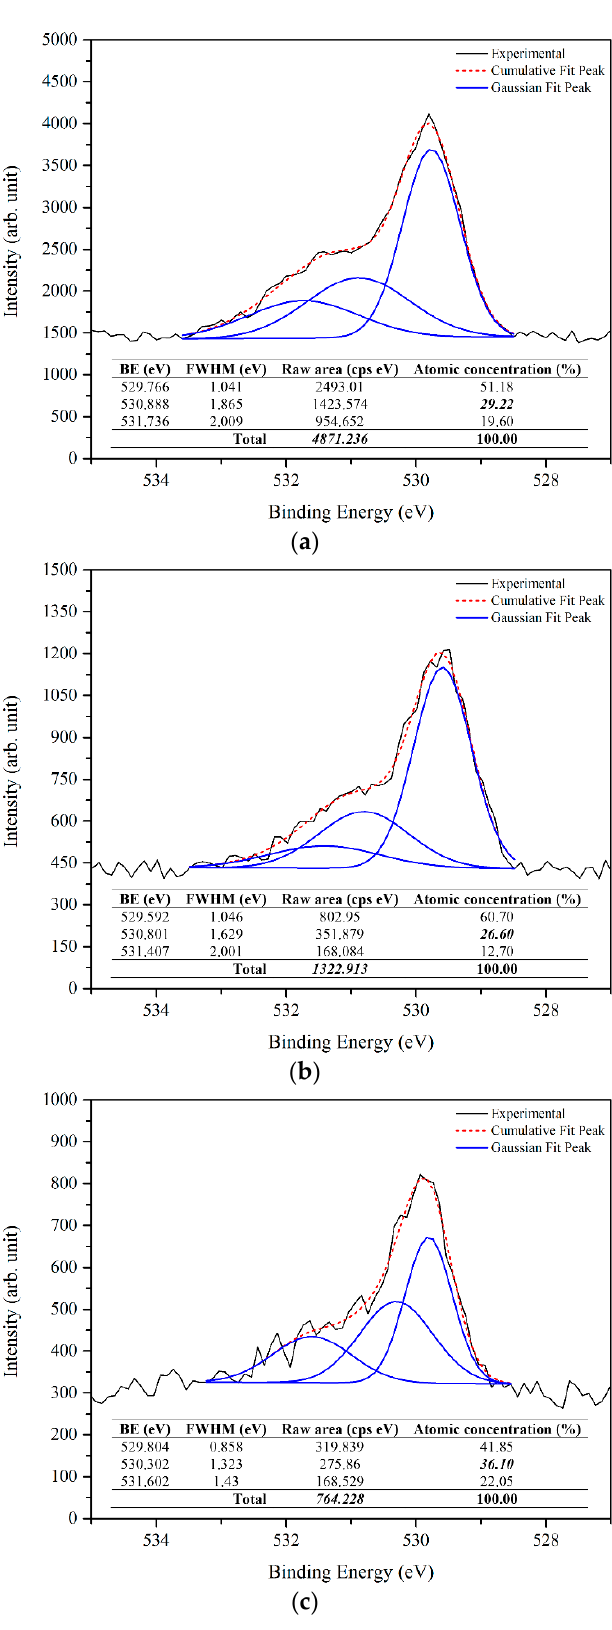
Figure 7. XPS analysis of oxygen 1s for as-deposited ZnO product grown at: ( a ) 500 C; ( b ) 600 C; and ( c ) 700 C.